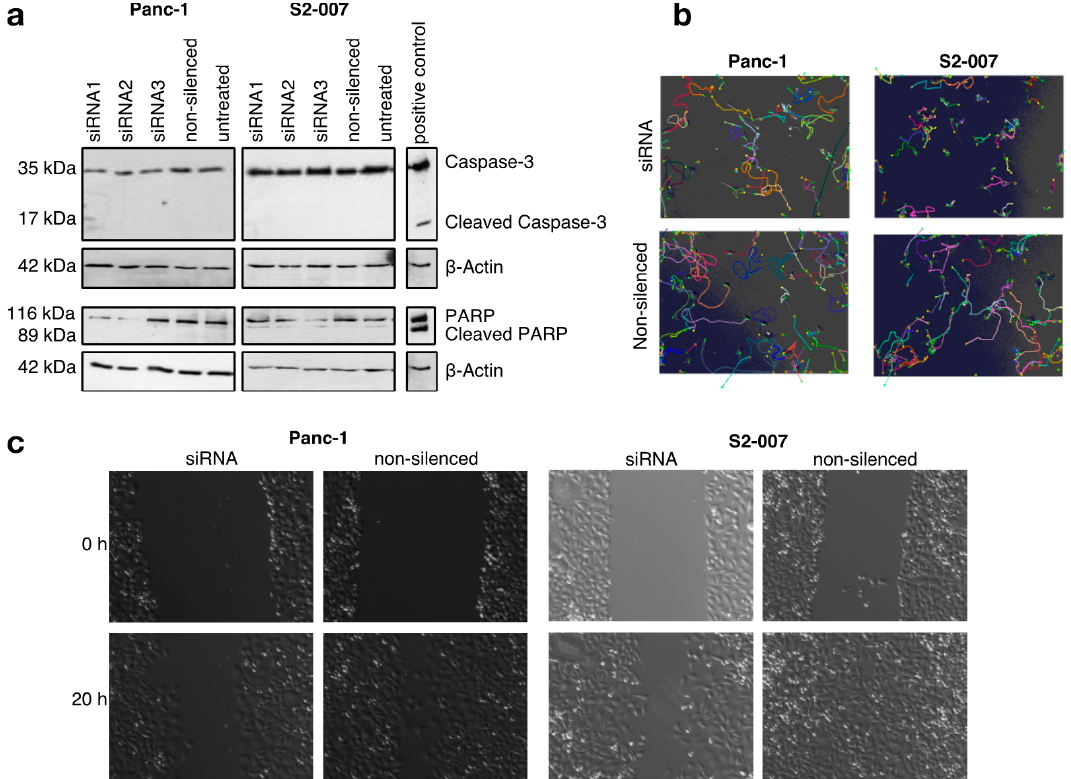
Figure 2. CFL1 knockdown does not induce apoptosis but reduces migration in pancreatic cancer cells ( a ) Western blot analyses with antibodies against full-length and cleaved caspase 3 (upper panels) as well as full length and cleaved poly (ADP-ribose) polymerase (PARP) (lower panels) were performed to check for apoptosis-inducing effects of CFL1 knockdown. UV-treated S2-007 cells served as positive controls for both markers. β -actin was used to ensure equal loading. No cleavage of caspase-3 or PARP was observed following CFL1 knockdown. The results are representatives of three independent experiments. ( b ) Automated time-lapse microscopy was used to determine average cell velocities of individual cells in subconfluent cultures or ( c ) rates of wound closure in confluent cultures of Panc-1 and S2-007 cells. Pictures are representatives of the